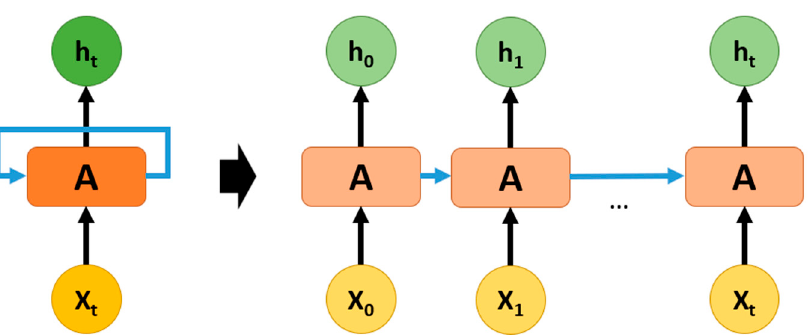
Figure 11. Recurrent Neural Network unrolled equivalent.